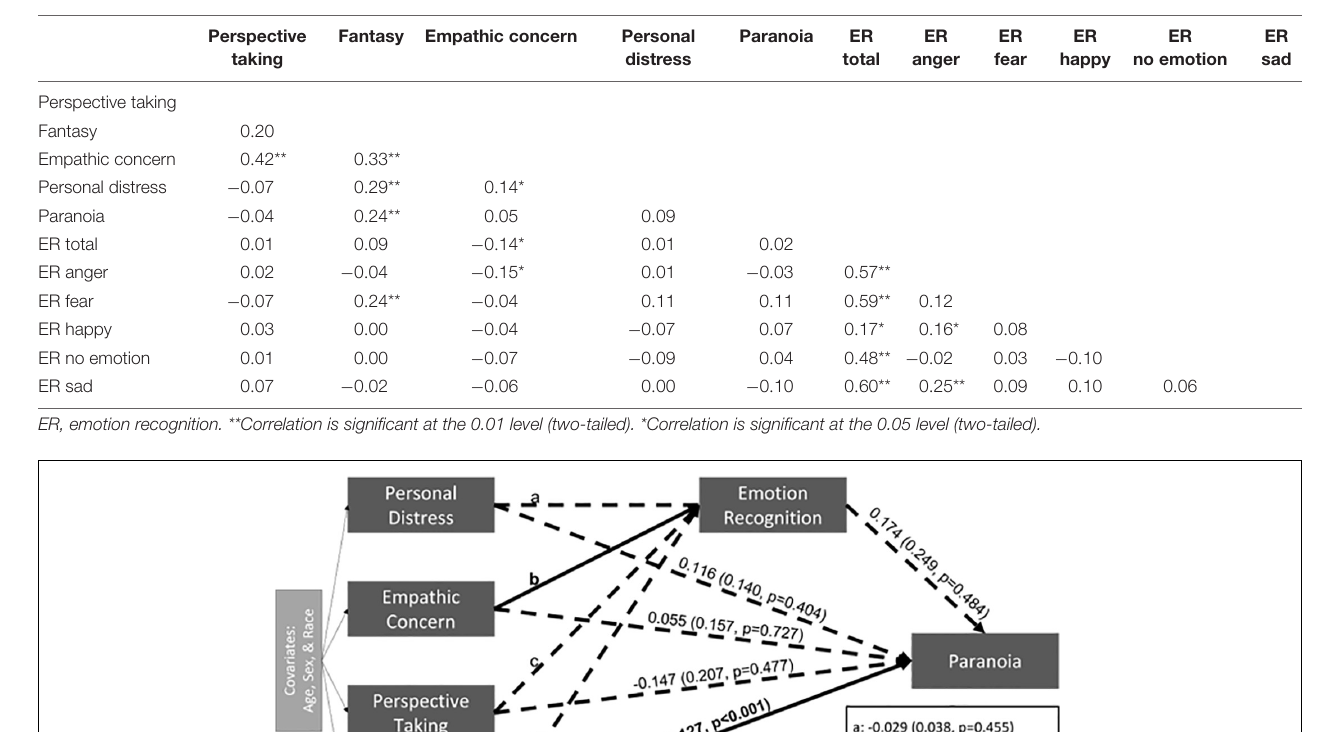
TABLE 2 | Zero-order